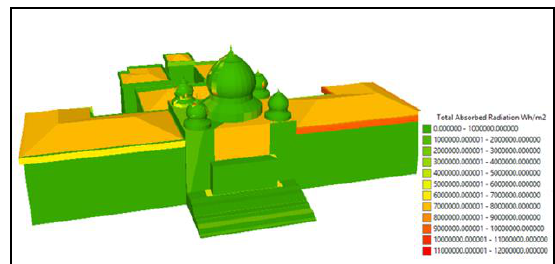
Figure 9. The simulation of solar absorption viewed in ArcScene